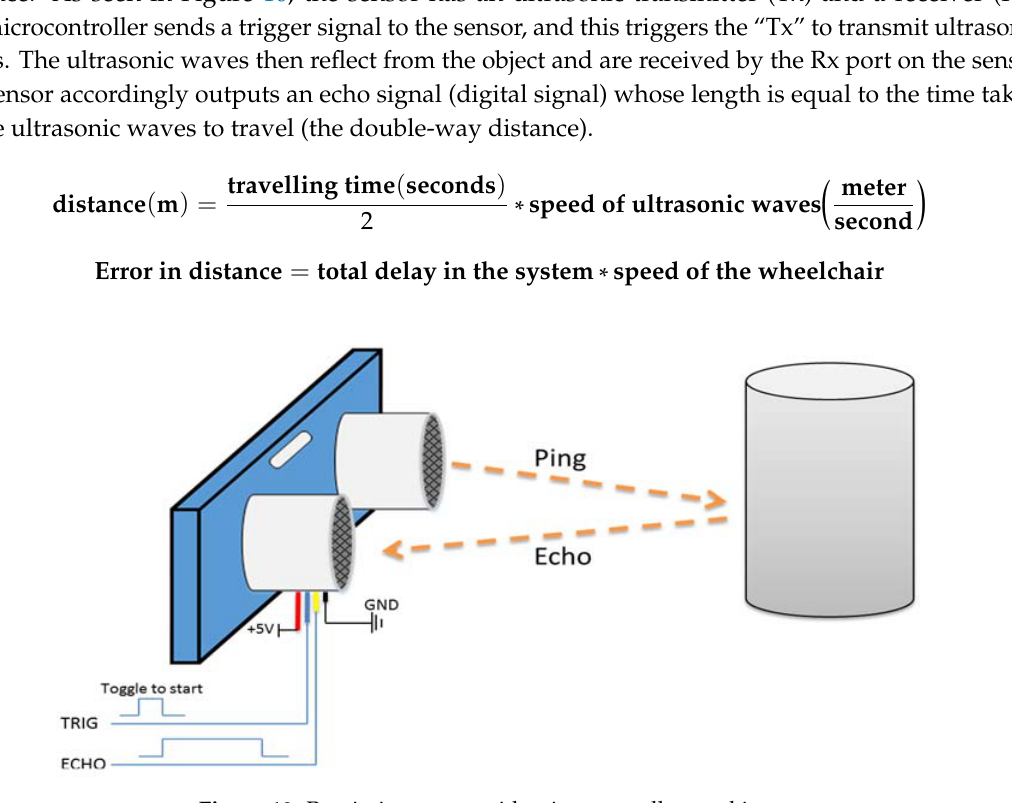
Figure 10. Proximity sensor with microcontroller working.